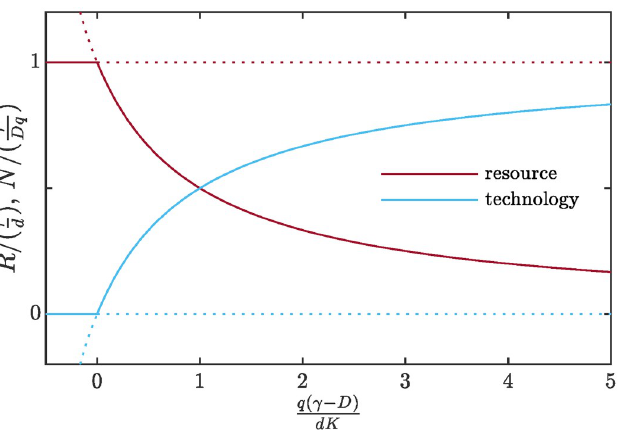
Fig 6. Bifurcation diagram for system (19). The solid lines depict stable behavior and the dotted lines depict unstable behavior. For D < γ , there is an unstable fixed point F 1 (ref. Eq (23a)) and a stable fixed point F 2 (ref. Eq (23b)). As D increases toward γ , fixed point F 2 approaches fixed point F 1 , and coalesces with it when D = γ . Finally, when D > γ , fixed point F 2 has become unstable, and fixed point F 1 is now stable. There is an exchange of stabilities between the two fixed points.